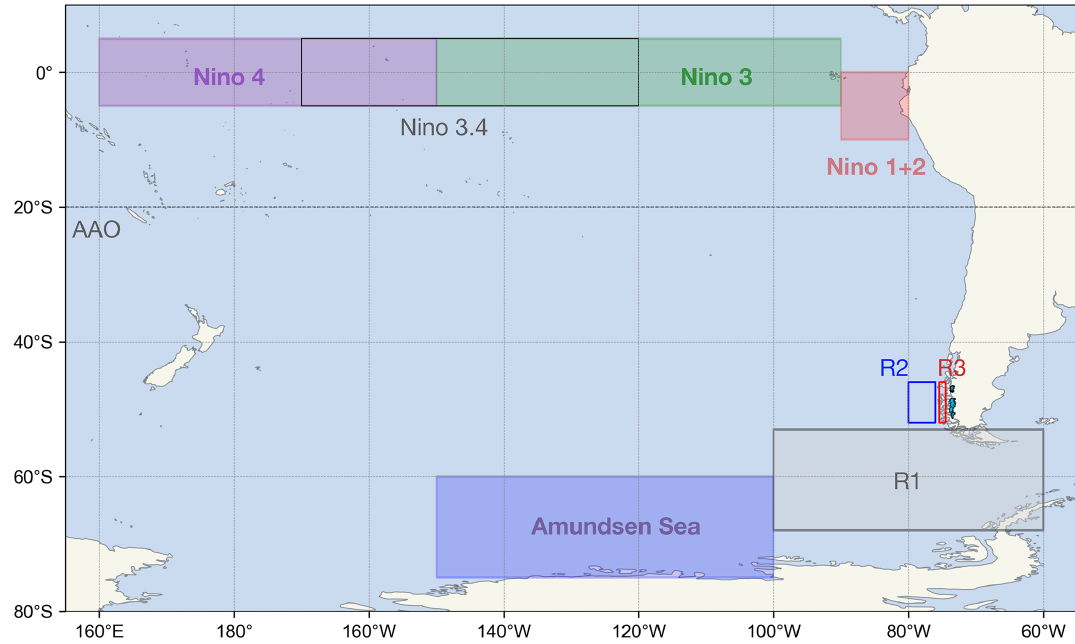
Figure 3. Regions used for the construction of climate indices.